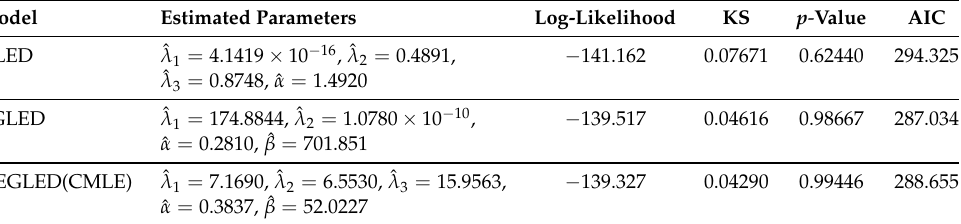
Table 12. The MLE of the model parameters, the values of log-likelihood function, the KS test statistics, the p -values of the KS tests, and the values of the AIC for three selected